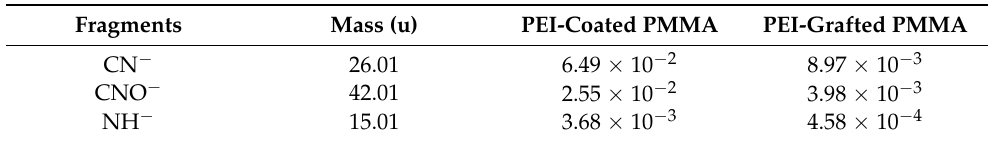
Table 2. Fragment intensities of TOF-SIMS for PEI-coated PMMA and PEI-grafted PMMA normalized to the total ion